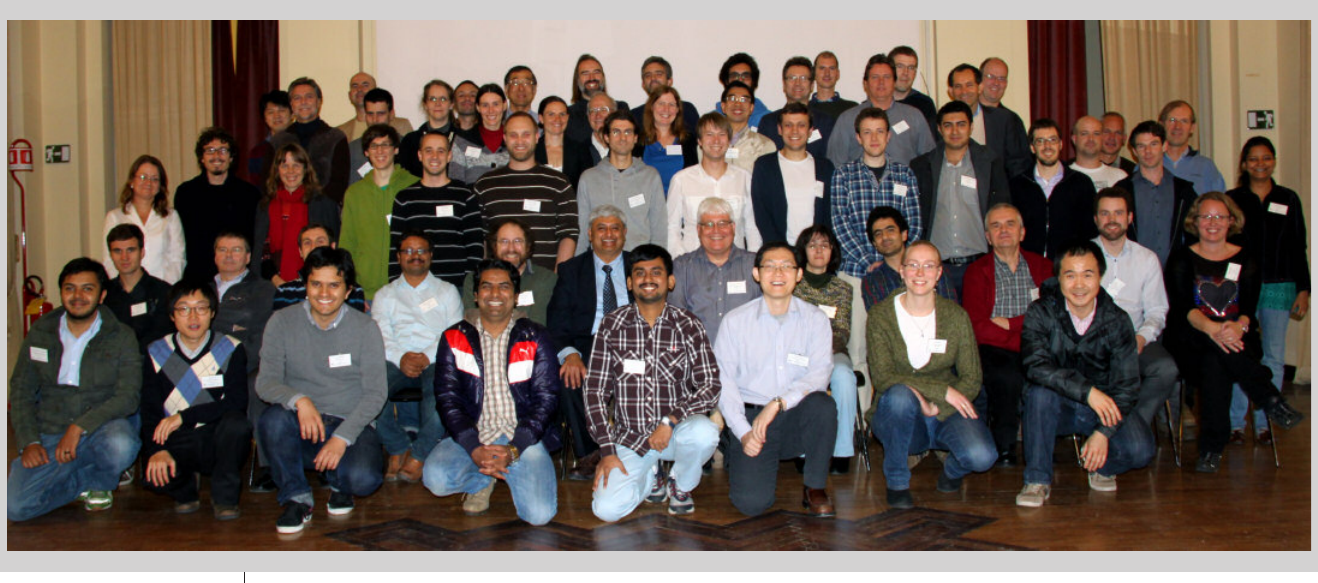
Figure 1: Group photo of the partici- pants of the